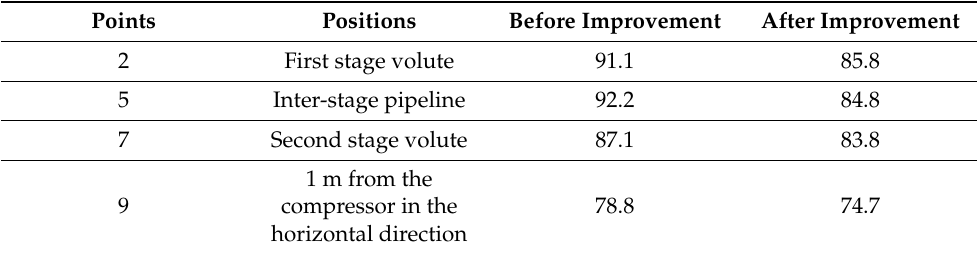
Table 11. Sound pressure level before and after improvement [dBA].